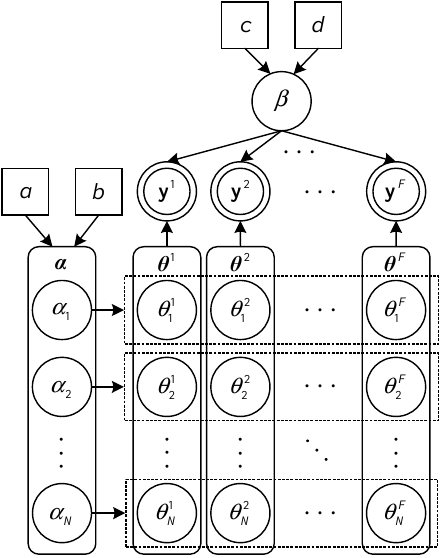
Figure 3. A hierarchical Bayesian model for joint sparse